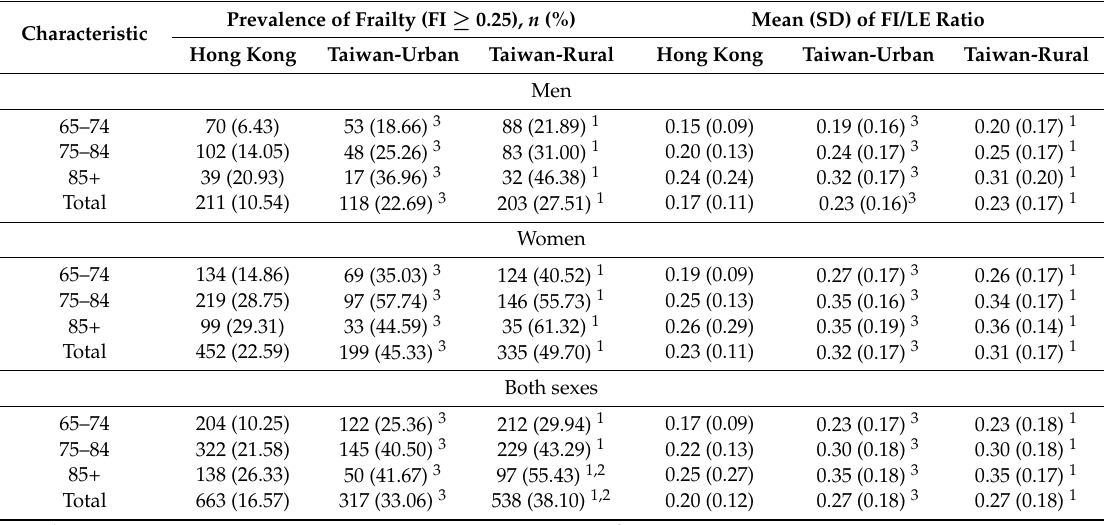
Table 3. Prevalence of frailty and mean of frailty index (FI)/life expectancy at birth (LE) in different areas by age and sex.